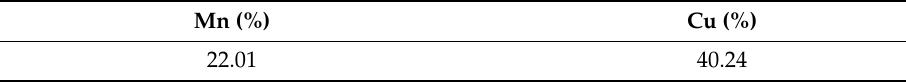
Table 2. Chemical analysis of the mineral.